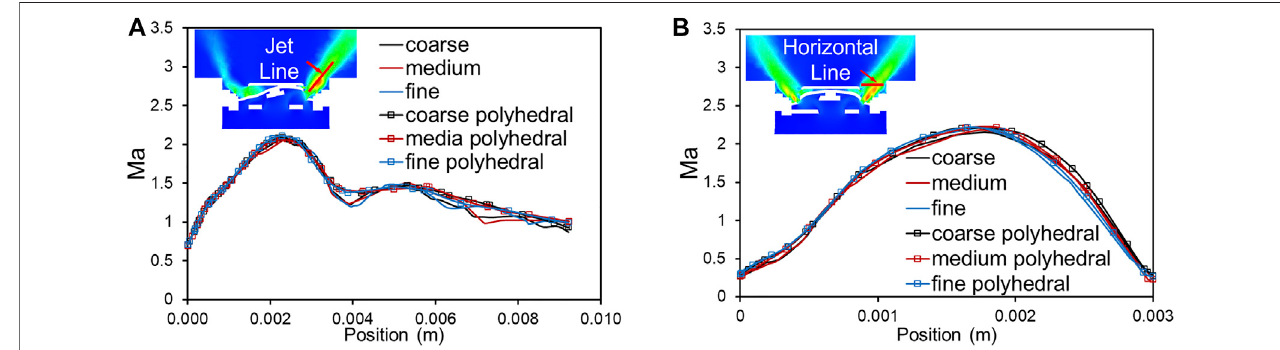
FIGURE4| MeshsensitivityanalysisconductedontheLGMJ1capat P 1 /P 2 (cid:1) 7showingMachnumberalongthejetline (A) andalongthehorizontallineacrossthe vent opening (B) .